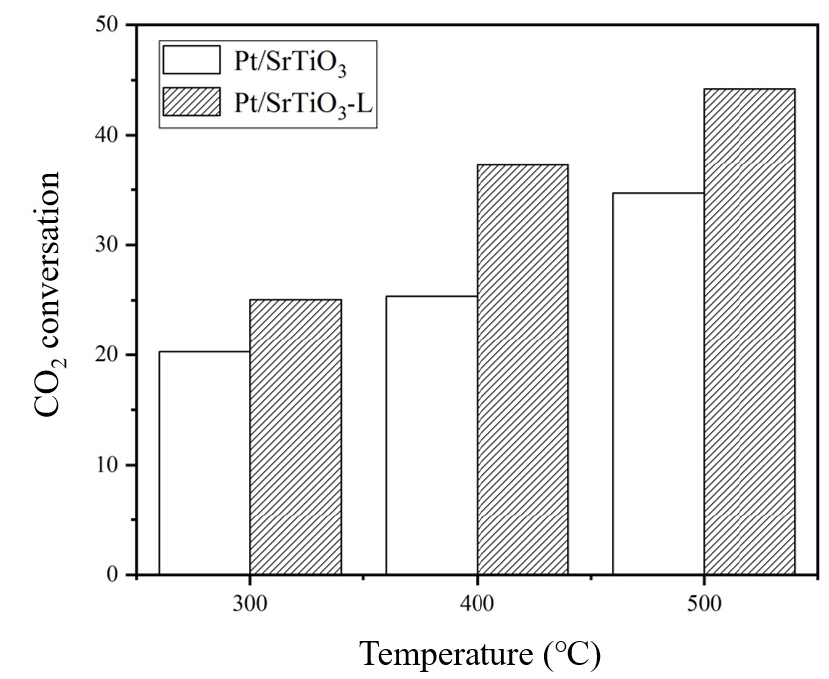
Figure 1. Catalytic performance of catalysts in RWGS at various temperatures. Table 1. TOFs of Pt/SrTiO 3 -L catalyst in RWGS reaction at different temperatures. 300 400 500 TOF (s − 1 ) 0.154 0.455 0.643